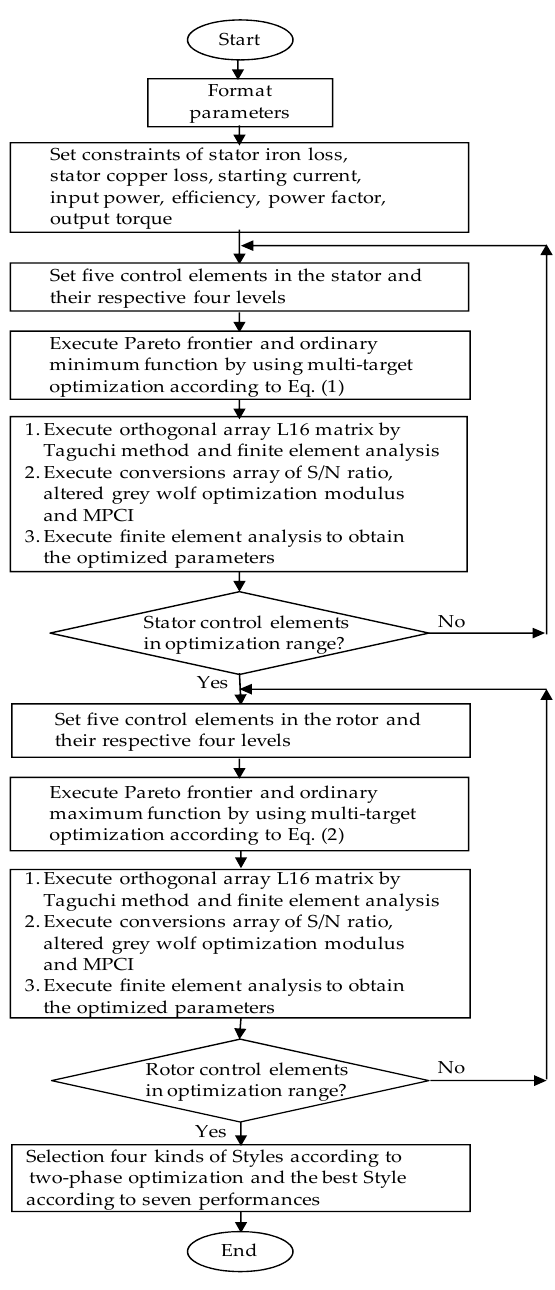
Figure 2. Flow chart of the optimization procedure with two-phase multi-objective optimization for SCSCRIM design.